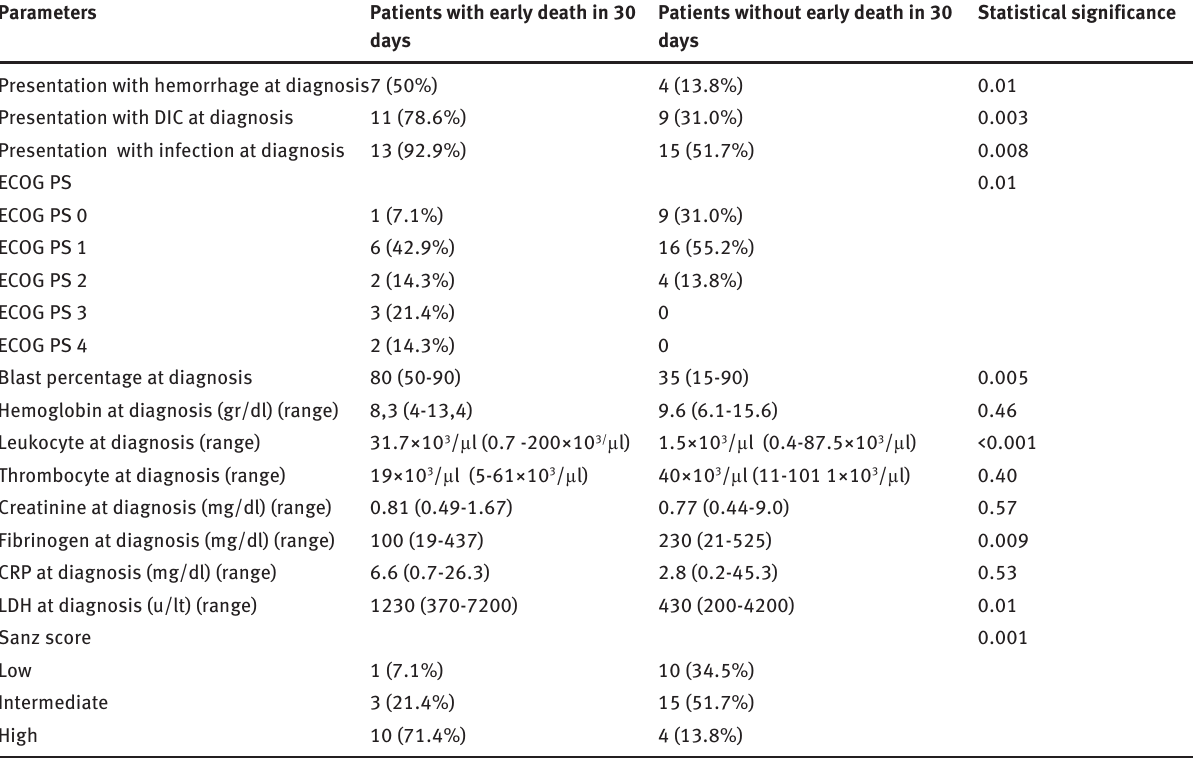
Table 2: Univariate analysis of parameters affecting early death in 30 days after diagnosis